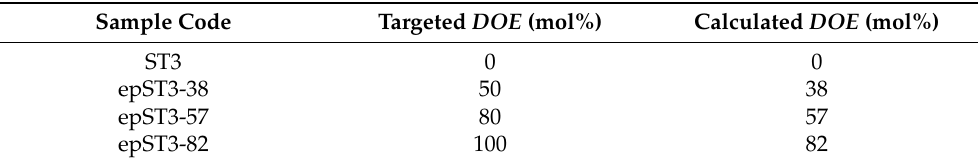
Table 1. Degree of epoxidation ( DOE ) of ST and epST-x.